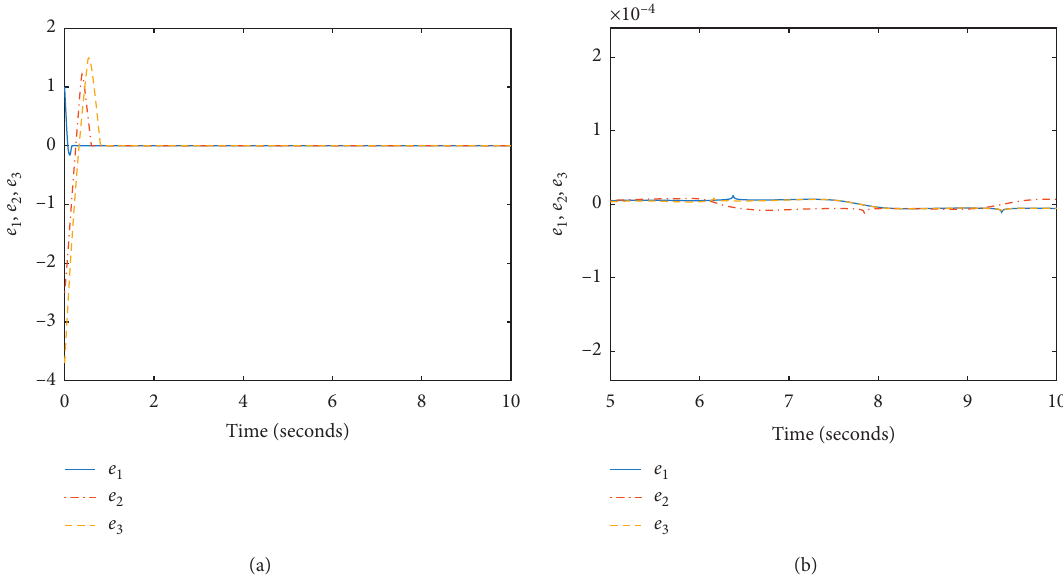
Figure 3: The trajectories of tracking errors e